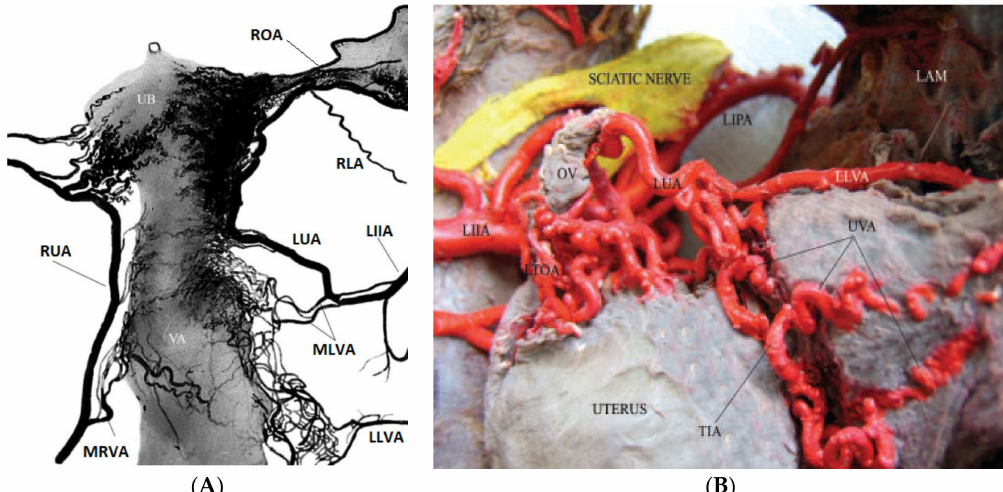
Figure 1. ( A ) Arteriography of the uterus, ovaries, fallopian tubes, and upper vaginal segment. With permission from Ref (Belou P. Atlas estereosco’pico de anatomı’a de las arterias del hombre. Tomo III 2da parte. En: Revisi ó n anat ó mica del sistema arterial (Stereoscopic Atlas of Human Arterial Anatomy. Volume 3; 2nd Part in: Anatomic Revision of Arterial System). Buenos Aires: El Ateneo, 1934:98–119). LIIA, left internal iliac artery; LLVA, lower left vaginal artery; LUA, left uterine artery; MLVA, middle left vaginal artery; MRVA, middle right vaginal artery; RLA, round ligament artery; ROA, right ovarian artery; RUA, right uterine artery; UB, the uterine body; VA, vagina. ( B ) Cadaveric specimen. Upper and left view of the genital- urinary organs. In the middle sector of the illustration, a thick intrauterine anastomosis can be identified. Below, thick vaginal branches anastomosing with the uterine artery can be observed. LAM, levator ani muscle; LIIA, left internal iliac artery; LIPA, left internal pudendal artery; LLVA, lower left vaginal artery; LTOA, left tubo-ovarian artery; LUA, left uterine artery; OV, ovary; TIA, transmedial inter uterine anastomosis; UVA, uterovaginal anastomosis [54]. Figure license number: